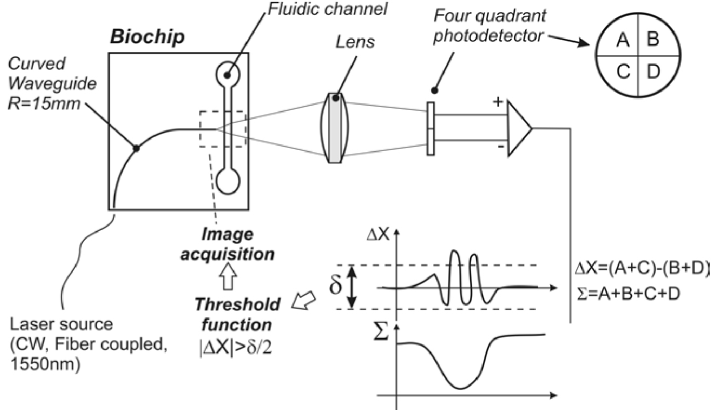
Figure 9. Schematic of biochip working principle: the biochip consists of a fluidic channel and a curved waveguide buried in the glass. A Gaussian beam emitted by a single-mode fibre is coupled into the biochip waveguide and diverges to illuminate a small length of the fluidic channel. Objects that pass through the fluidic channel momentarily distort the beam intensity profile. The light from the biochips is then refocused onto a four-quad detector to monitor small intensity changes. Reprinted with permission from [115]. Copyright 2011, Optica Publishing